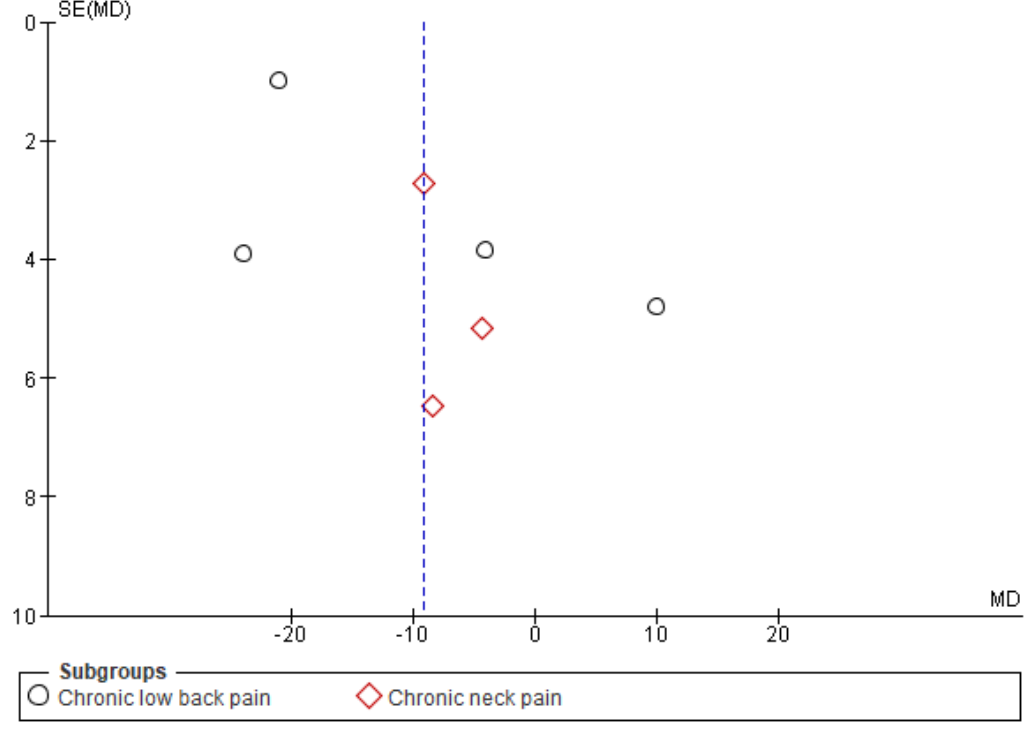
Figure 12. Funnel plot VR pain management intervention group vs. control group.